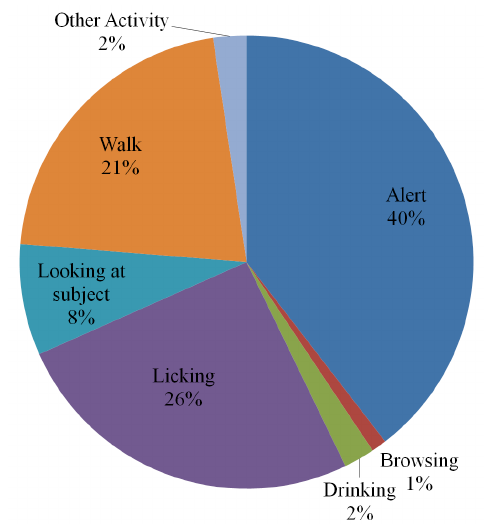
Figure 1. Average time spent by FHAs for different activity patterns in an open area of Babai Valley, Bardia National Park,